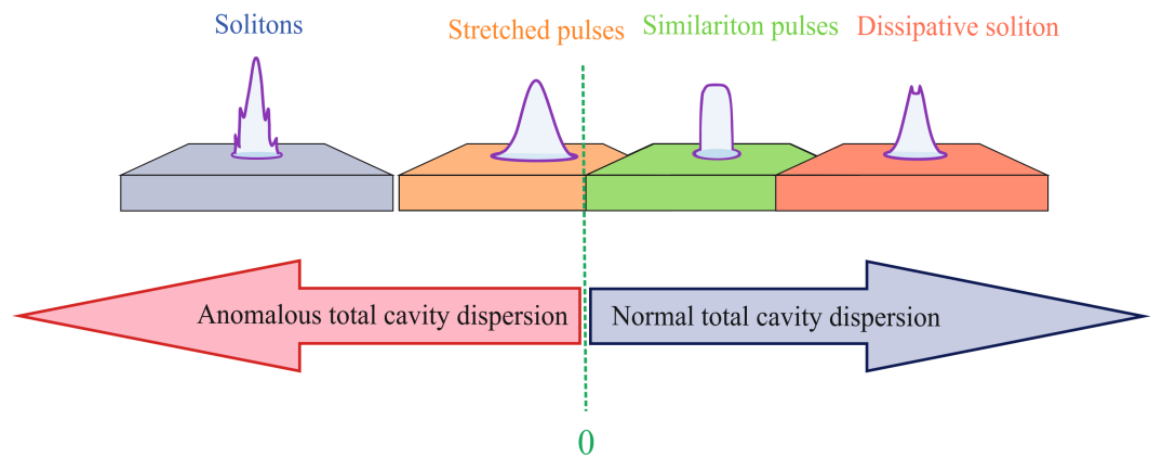
Figure 3. Simplified dependence of the generation regimes on the net-cavity total GVD value. The GVD, which changes the pulse duration, is not the only factor affecting radiation